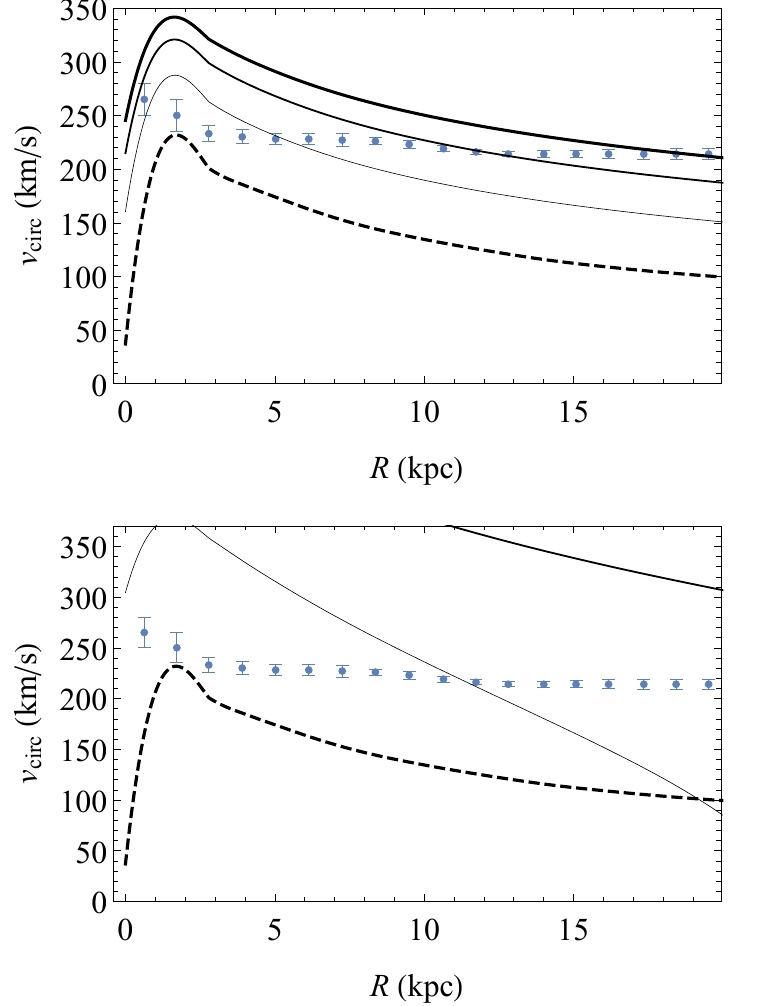
Figure 11 . Comparison of the data points of NGC7814 with the n = 0 rotation curve of the theory T with weighted derivatives in the extreme fractional regime with a data-based matter v density profile for α = 1 (Einstein’s theory, dashed curve), α = 0 . 90 , 0 . 86 , 0 . 84 (top panel, increasing thickness) or α = 2 / 3 and R = 3 , 10 kpc (bottom panel, increasing ∗